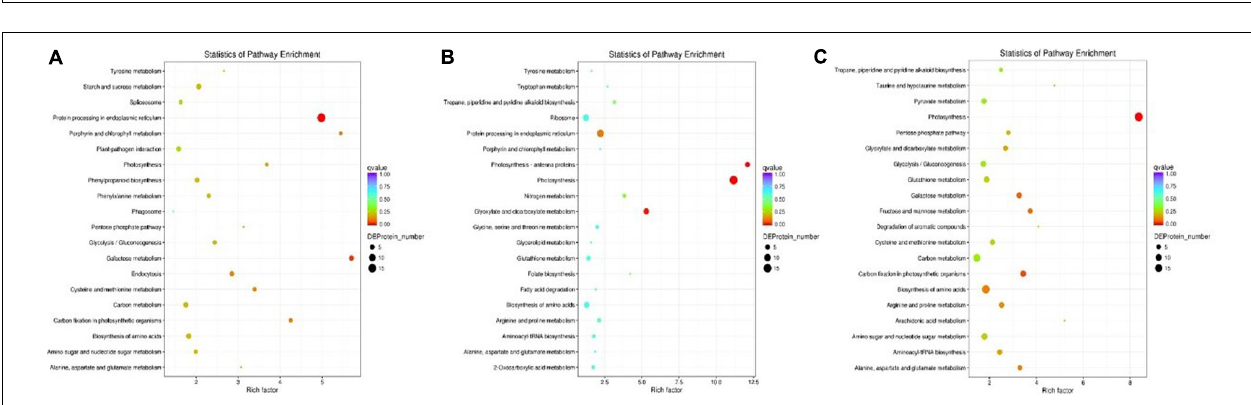
FIGURE 8 | KEGG pathway enrichment analysis of DEPs in the T0d vs. T10d (A) , T10d vs. T20d (B) , and T0d vs. T20d (C) groups. For details of the KEGG pathway analysis of the DEPs, see Supplementary Spreadsheet 5 .